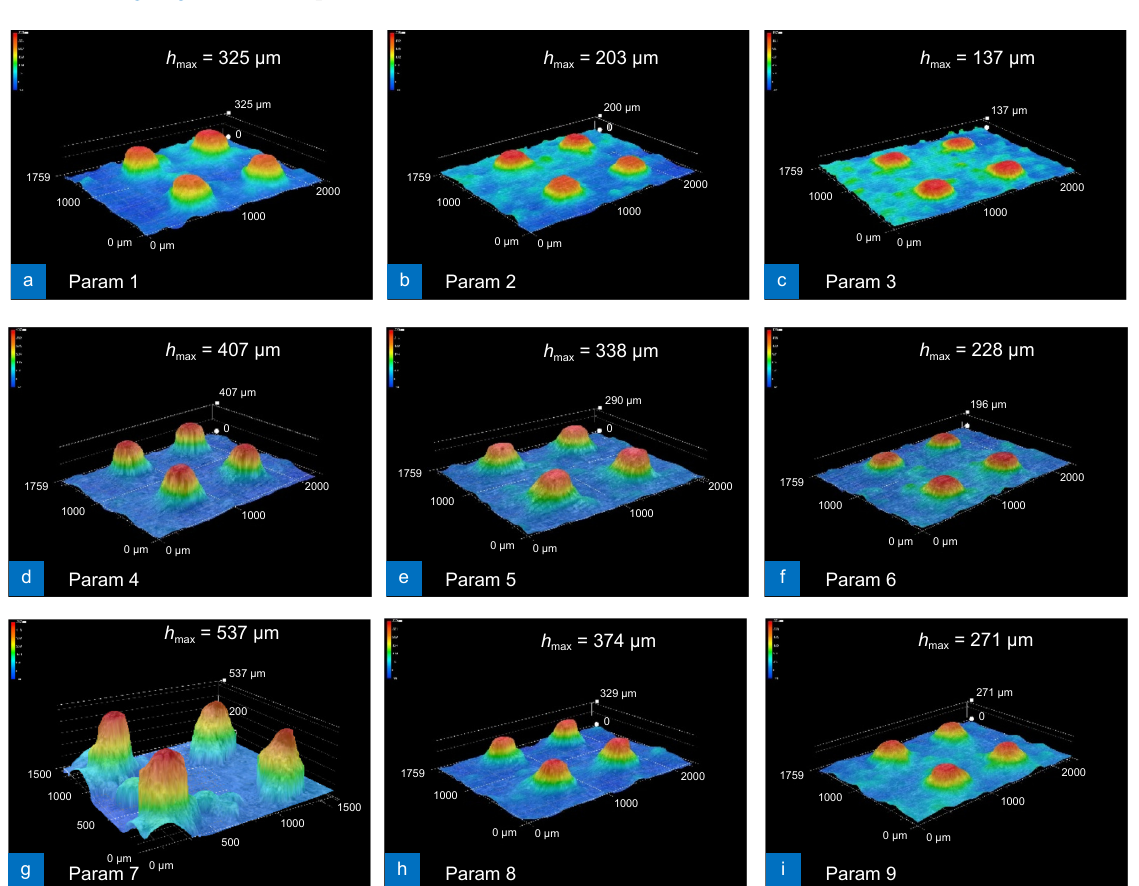
Fig. 4 | Surface morphologies of microstructures fabricated with different laser parameters imaged by a super deep scene 3D micro- scope. ( a ) Param 1 : f = 35 kHz, v = 100 mm·s -1 ; ( b ) Param 2 : f = 35 kHz, v = 150 mm·s -1 ; ( c ) Param 3 : f = 35 kHz, v = 200 mm·s -1 ; ( d ) Param 4 : f = 40 kHz, v = 100 mm·s -1 ; ( e ) Param 5 : f = 40 kHz, v = 150 mm·s -1 ; ( f ) Param 6 : f = 40 kHz, v = 200 mm·s -1 ; ( g ) Param 7 : f = 45 kHz, v = 100 mm·s -1 ; ( h ) Param 8 : f = 45 kHz, v = 150 mm·s -1 ; ( i ) Param 9 : f = 45 kHz, v = 200 mm·s -1